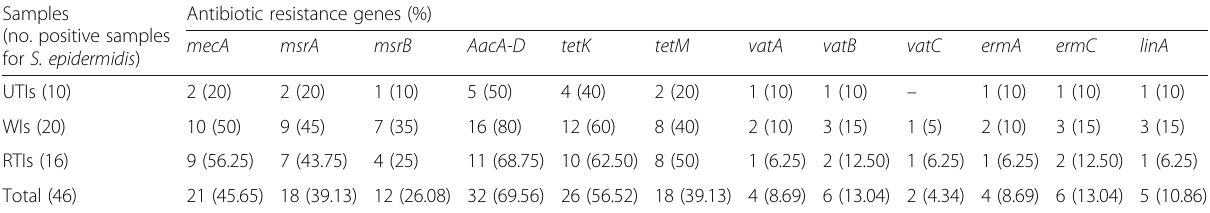
Table 2 Distribution of antibiotic resistance genes amongst the S. epidermidis strains isolated from different types of hospital infectious samples Samples (no. positive samples for S. epidermidis )